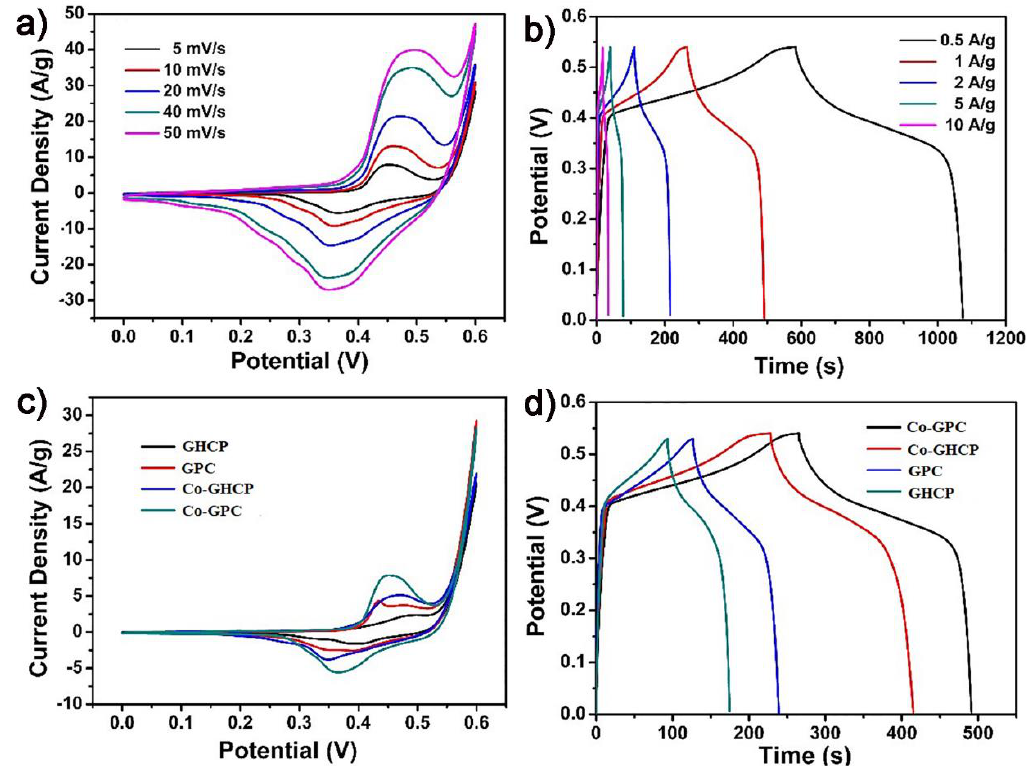
Figure 5. ( a ) Cyclic voltammograms (CV) of the Co-GPC electrodes at various scan rates; ( b ) The galvanostatic charge/discharge curves of the Co-GPC supercapacitor at various specific currents; ( c ) CV of Co-GHCP, Co-GPC, GHCP, and GPC at 10 mV s − 1 ; ( d ) The charge/discharge curves of the Co-GHCP, Co-GPC, GHCP, and GPC performed at the current density of 1 A g −1.